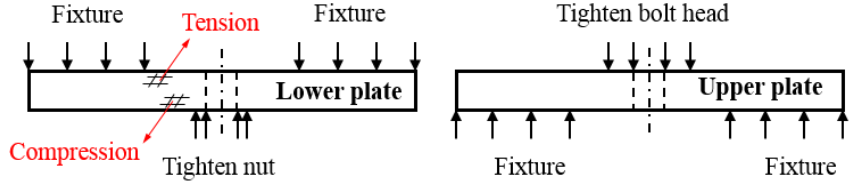
Figure 8. Failure morphology of the ( a ) top and bottom surfaces and the ( b ) side of the lower lap plate. Figure 9. Load on the lap plate.